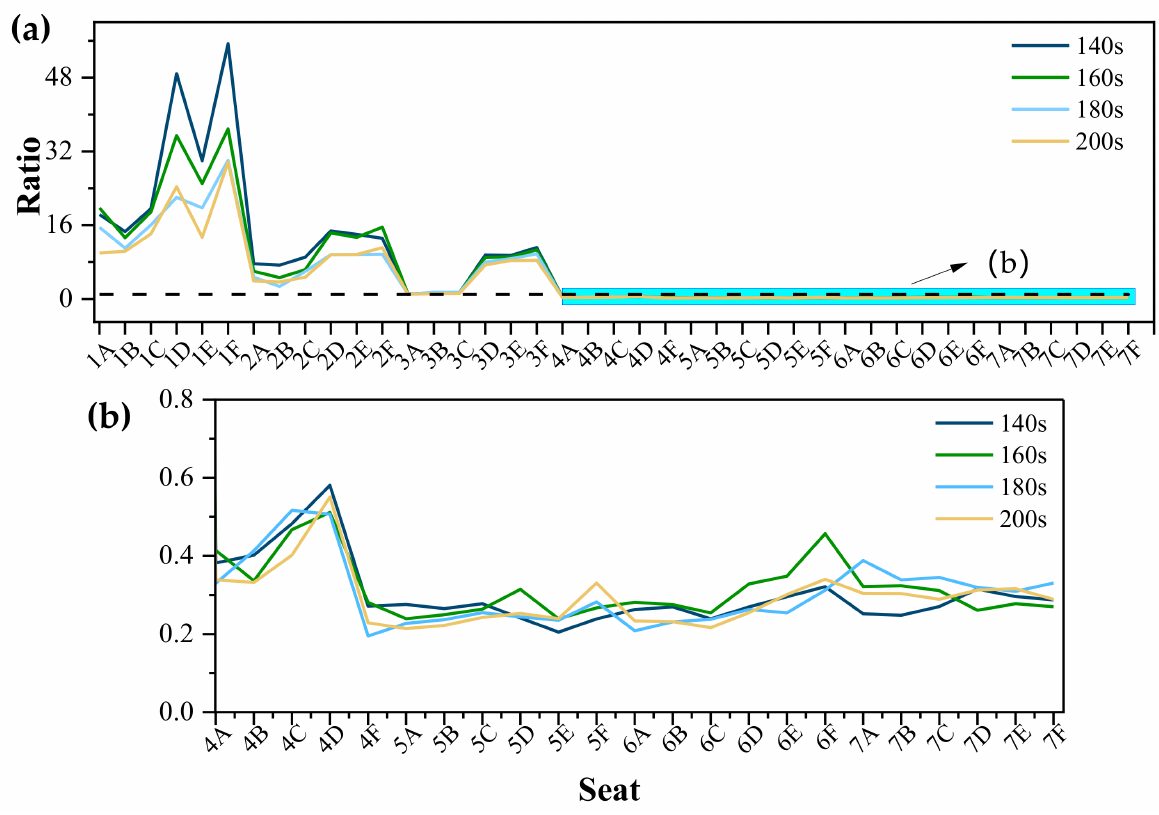
Figure 6. Passenger SEI ratio under virus carrier’s cough over normal breath (( a )SEI ration; (b) the results for passengers in rows 4 to 7 are enlarged in ( b